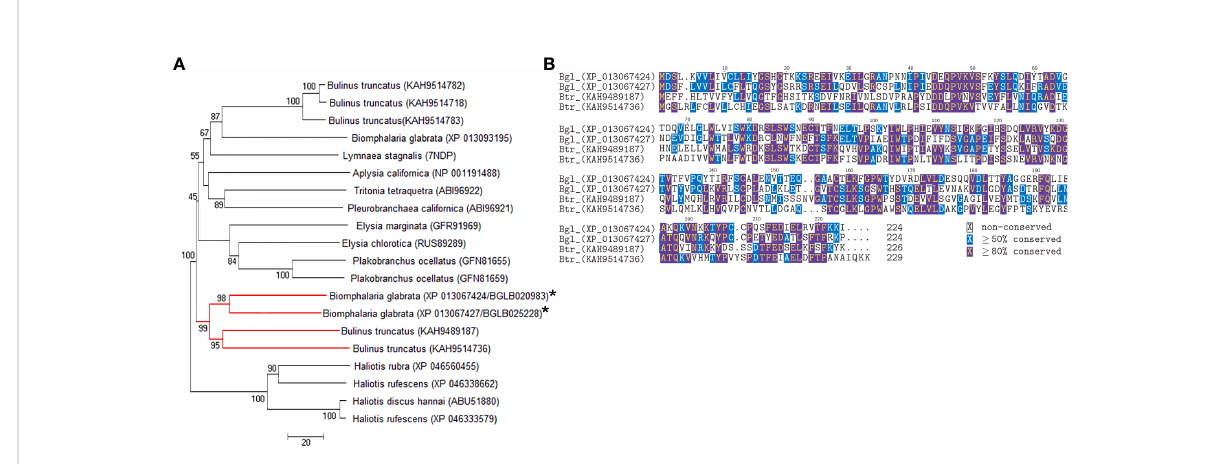
FIGURE 3 Comparative analysis of AChBP-like proteins in molluscs. (A) Phylogenetic analysis with B glabrata proteins identi fi ed in SCW denoted with asterisk and the red branch demonstrating the clade of interest. (B) Protein multiple sequence alignment. Bgl, B glabrata ; Btr, B truncatus